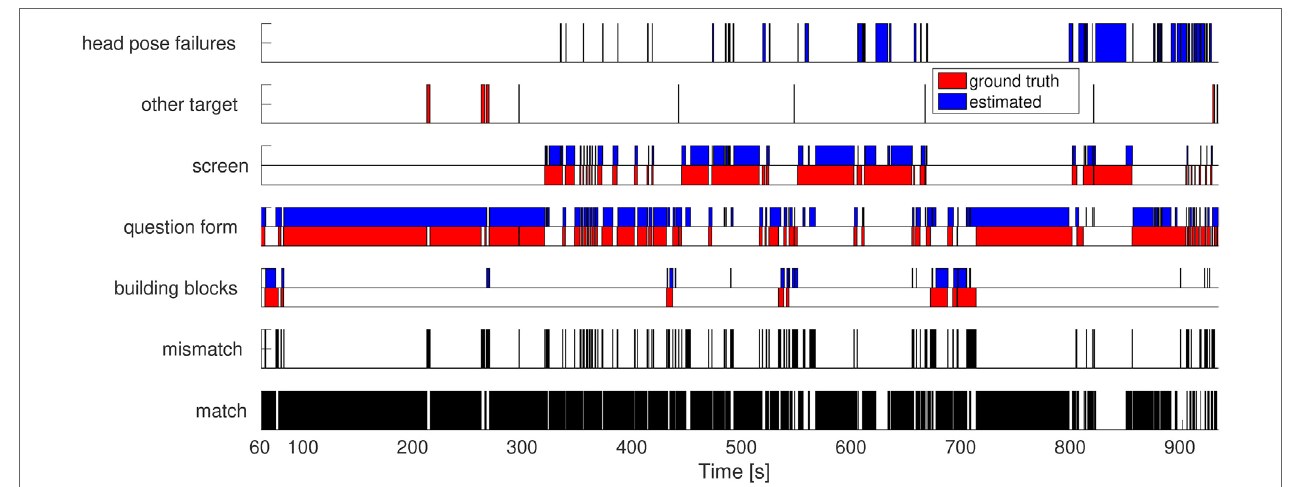
FigUre 7 | Comparison of estimated and ground truth targets of attention for the Participant 2. The head pose tracker’s failures are not